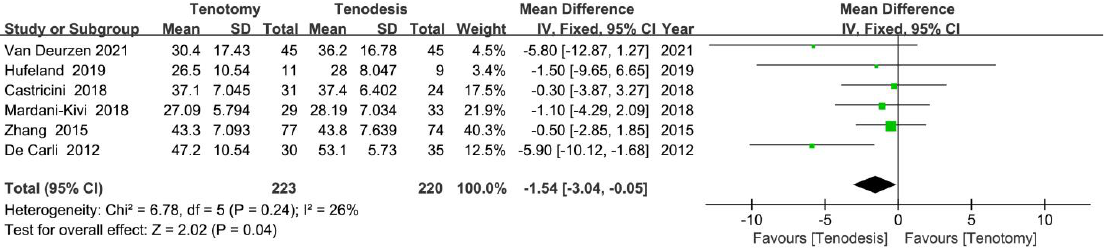
Figure 4. Meta-analysis of randomised controlled trials showing the Constant score improvement from baseline was greater in the patients who underwent tenodesis. Green symbol: mean difference value; Black symbol: result of meta-analysis. Table 3. Summary of subgroup analyses of Constant score improvement.